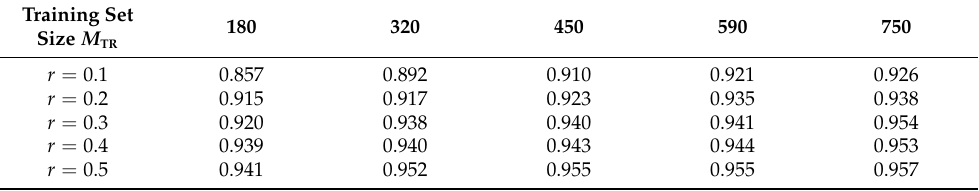
Table 3. The AUROC performance of the proposed algorithm with various training set sizes M various values of ITR ratio r . The AUROC measurements were based on the same testing